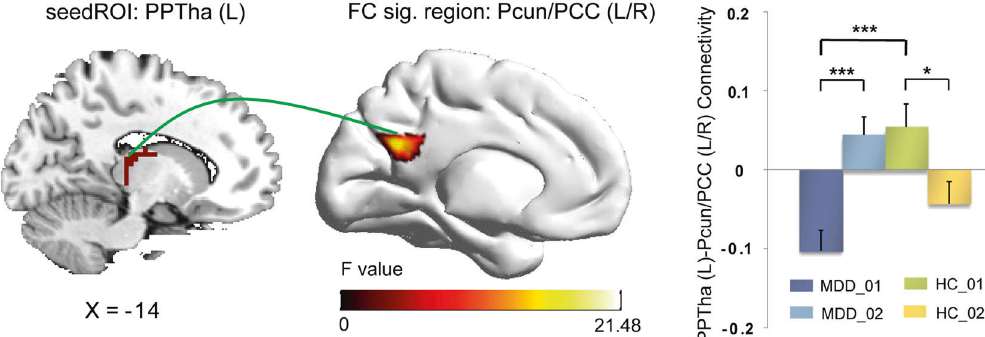
Fig. 4 Interaction effect of Diagnosis × BMRM. BMRM had the different effect on the healthy controls and MDD patients in the functional connectivity between the left posterior parietal thalamus (PPTha) and the bilateral precuneus/posterior Cingulate Gyrus (PCun/PCC). After the BMRM, the MDD patients demonstrated signi fi cantly increased FC in left Pptha-bilateral PCun/PCC (turn from negative FC into positive FC), while the HCs demonstrated decreased FC in left PPTha-bilateral PCun/PCC. BMRM body – mind relaxation meditation, L left, R right. *0.01 ≤ p < 0.05, **0.001 ≤ p < 0.01, *** p <